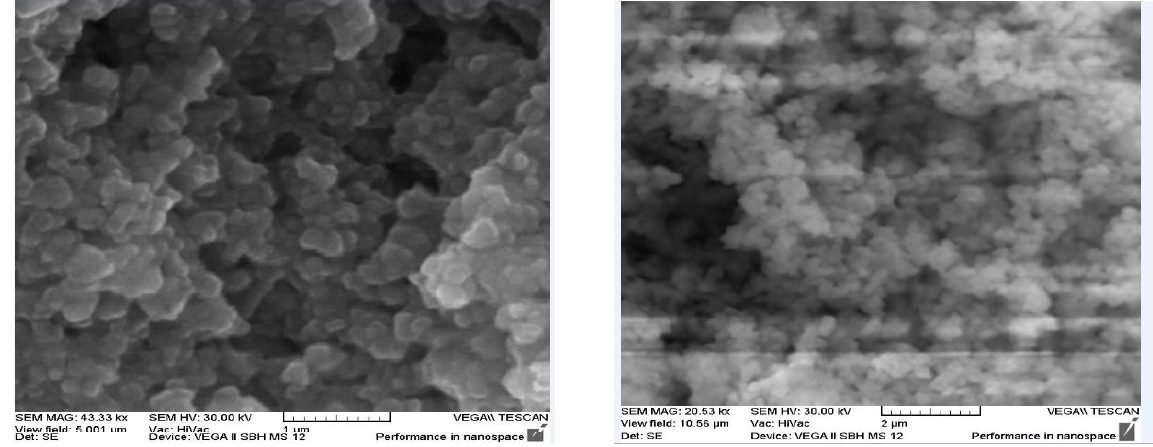
Fig.7: SEM picture of ZnS